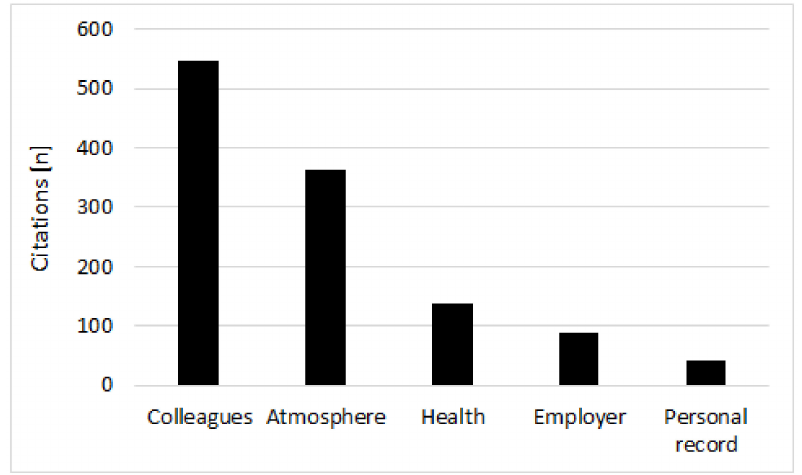
Figure 2. Motivations for participation as reported by the race participants.